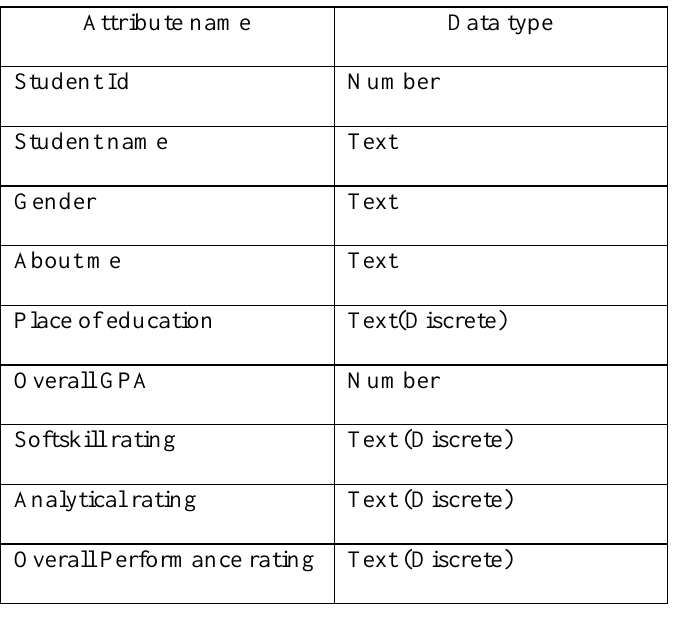
Web Data Attribute